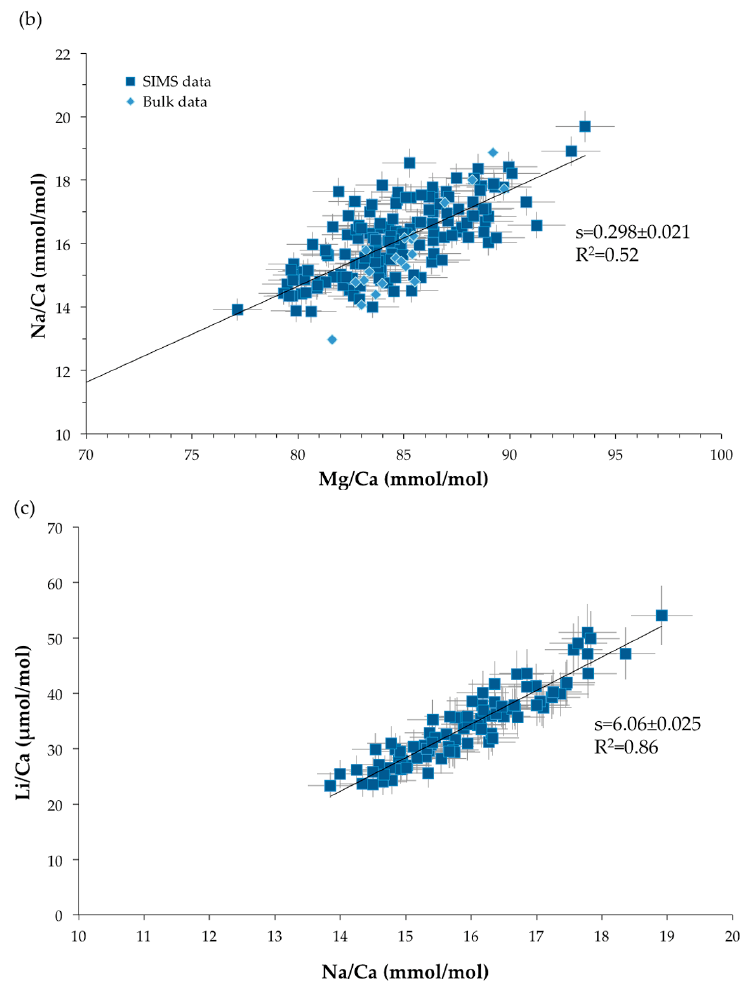
Figure 11. Relationships between TE/Ca ratios. s represents the slope of the linear correlation: ( a ) Li/Ca ( μ mol/mol) versus Mg/Ca (mmol/mol). ( b ) Na/Ca (mmol/mol) versus Mg/Ca (mmol/mol). The blue squares represent the SIMS measurements and the blue diamonds the bulk data. ( c ) Li/Ca ( μ mol/mol) versus Na/Ca (mmol/mol). Error bars are ±2 σ .